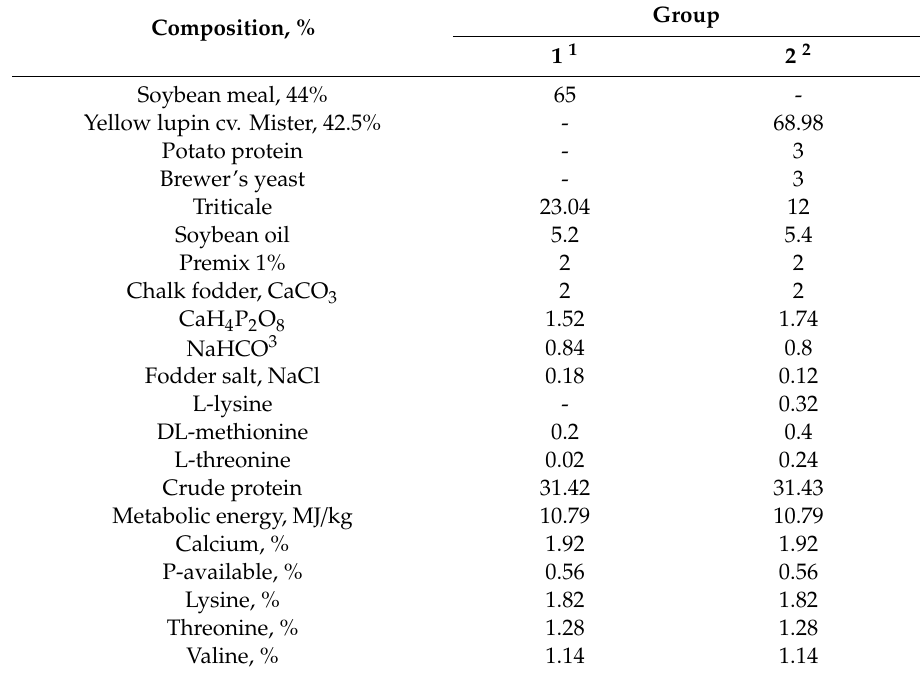
Table 2. Composition of concentrate and its analysed nutritive value for